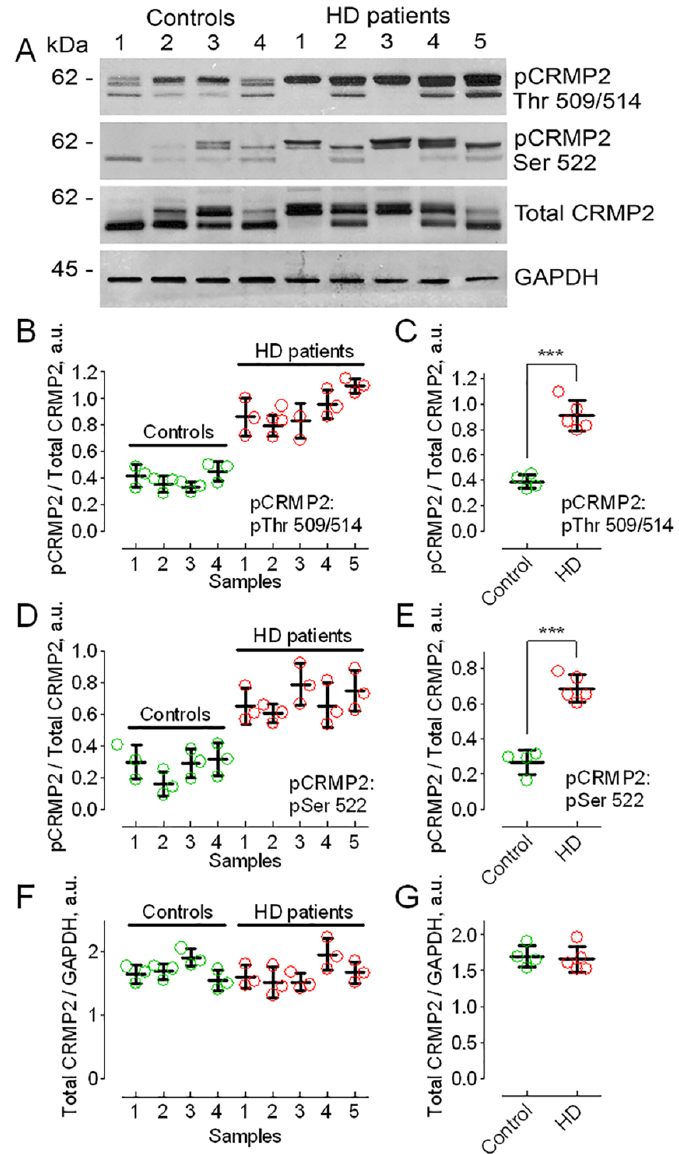
Figure 1. CRMP2 hyperphosphorylation in postmortem brain tissues of HD patients compared to postmortem brain samples of unaffected individuals. ( A ), Western blots with pCRMP2 antibodies for Thr 509/514 and Ser 522, total CRMP2, and GAPDH (loading control). Molecular weight markers (kilodalton, kDa) are indicated in the left margin of the blots. ( B – G ), densitometry data. All samples were immunoblotted three times ( B , D , F ), and then individual data were averaged across the different blots ( C , E , G ). Here, and in other figures, the data from individual experiments are shown as the colored circles. In ( B , D , F ), pCRMP2 are normalized by total CRMP2 and total CRMP2 are normalized by GAPDH in 9 individual samples from 4 control and 5 HD human brain samples, respectively. Here, and in other figures, the phosphorylation sites are indicated in the panels. Data are mean ± SD, N = 3 technical replicates (3 separate immunoblotting experiments). In ( C , E ), averaged pCRMP2 are normalized by total CRMP2 from individual samples pooled together for statistical analysis. Data are mean ± SD. N = 4–5, data are pooled together from separate immunoblotting experiments with 4 control and 5 HD human brain samples shown in ( B , D ), *** p < 0.001 comparing brain tissue from HD patients (HD) and unaffected individuals (control). In G , total CRMP2 normalized by GAPDH from experiments shown in ( F ). Data are mean ± SD. N = 4–5 separate immunoblotting experiments with 4 control and 5 HD human brain